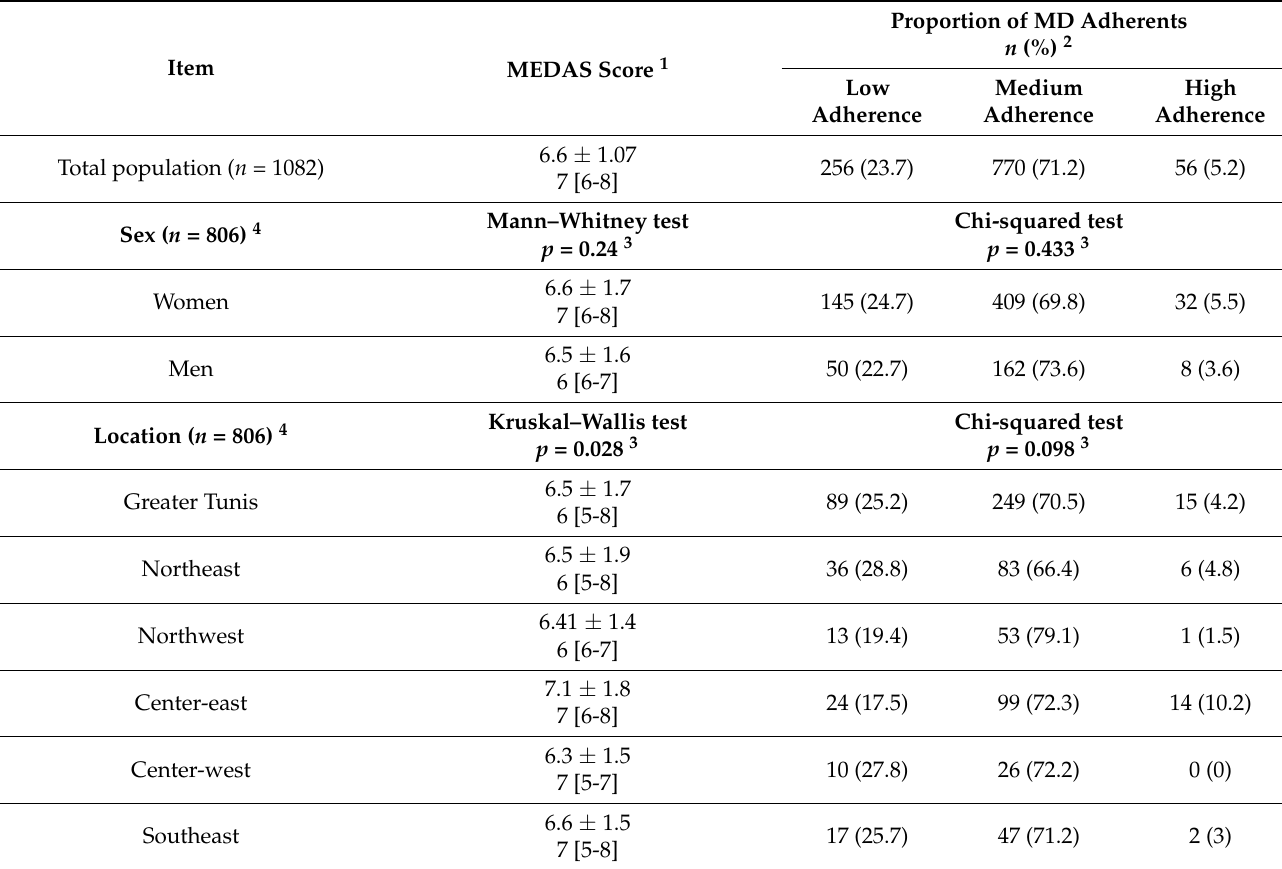
Table 3. Adherence to Mediterranean diet over sociodemographic